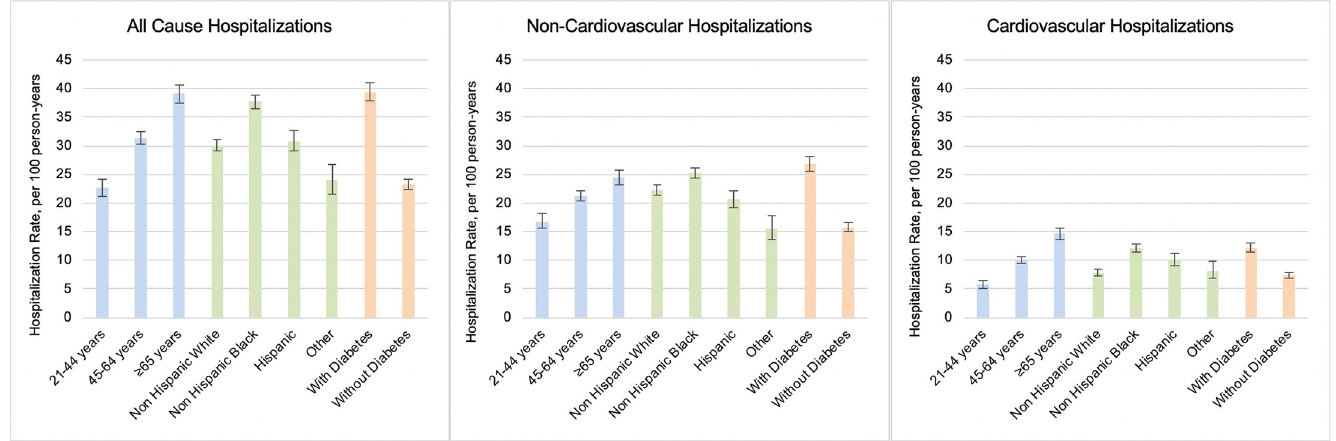
Fig 1. Age-, race-, and diabetes-adjusted rates for all-cause, non-cardiovascular, and cardiovascular hospitalizations in CRIC participants ( N = 3,939). Rates reported as per 100 PY. Error bars indicate 95% confidence intervals. CRIC, Chronic Renal Insufficiency Cohort; PY, person-years.